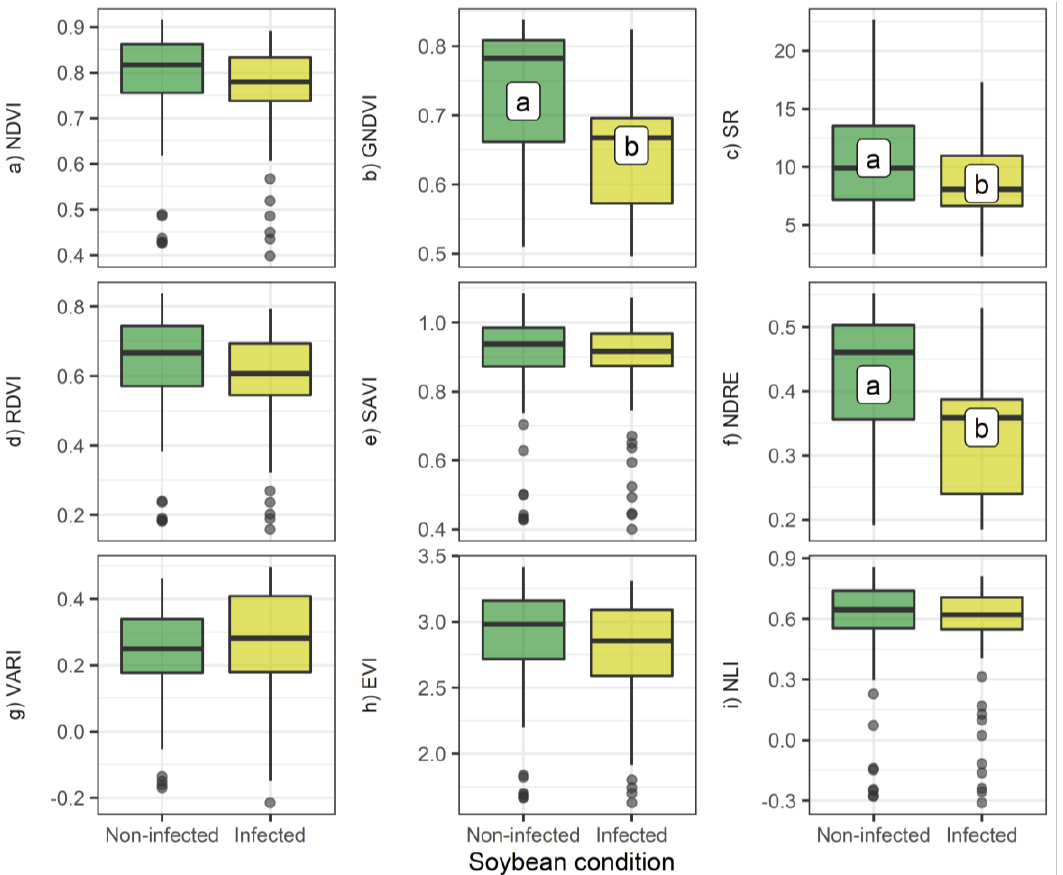
Figure 4. Boxplot representing the data distribution for VIs in different soybean conditions (asymp- tomatic in green, symptomatic in yellow). Boxplots portray the 25th (lower hinge), 50th (solid black line), and 75th (upper hinge) percentiles, largest value no further than 1.5 × inter-quartile range (lower whisker), smallest value at most 1.5 × inter-quartile range (upper whisker), and outlying observations (points). Different letters represent significant differences between conditions at α = 0.05. Further details on all description and abbreviations on the vegetation indices can be consulted in Table